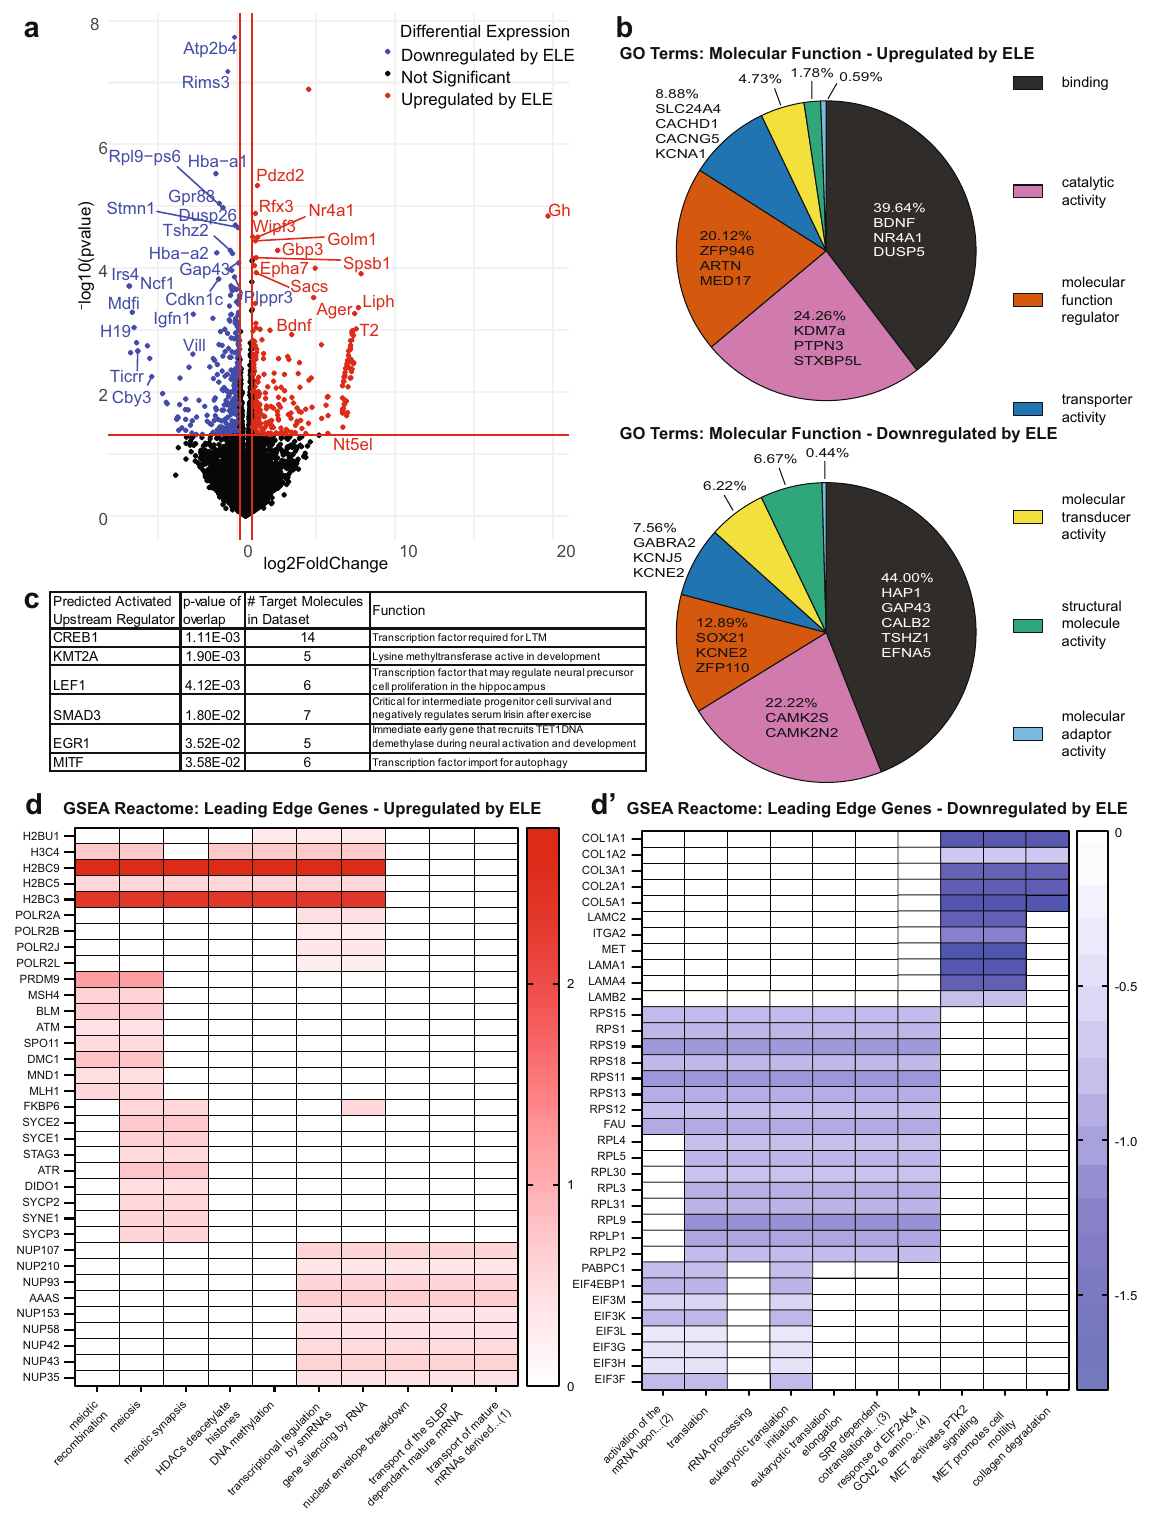
Fig. 4 ELE results in novel transcriptomic changes in hippocampal neurons during adolescence. a Volcano plot of differentially expressed genes reaching signi fi cance identi fi ed by TRAP-seq on ELE versus sedentary ( n = 2 sedentary mice and n = 3 ELE mice, absolute value log 2 fold change >0.3785 and p - value < 0.05). b Panther Gene Ontology: Molecular Function top terms by most genes assigned. c Top 6 “ Upstream Regulators ” identi fi ed by Ingenuity Pathway Analysis (IPA). d Representative Gene Set Enrichment Analysis: Reactome leading-edge diagrams showing genes upregulated ( d ) or downregulated ( d ′ ) in ELE, and their categories of enrichment. *Abbreviated terms in d : (1) “ transport of mature mRNAs derived from intronless transcripts ” , d ′ : (2) “ activation of the mRNA upon binding of the cap binding complex and EIFs and subsequent binding to 43S ” , (3) srp-dependent cotranslational protein targeting to membrane, and (4) response of eif2ak4 gcn2 to amino acid de fi ciency.